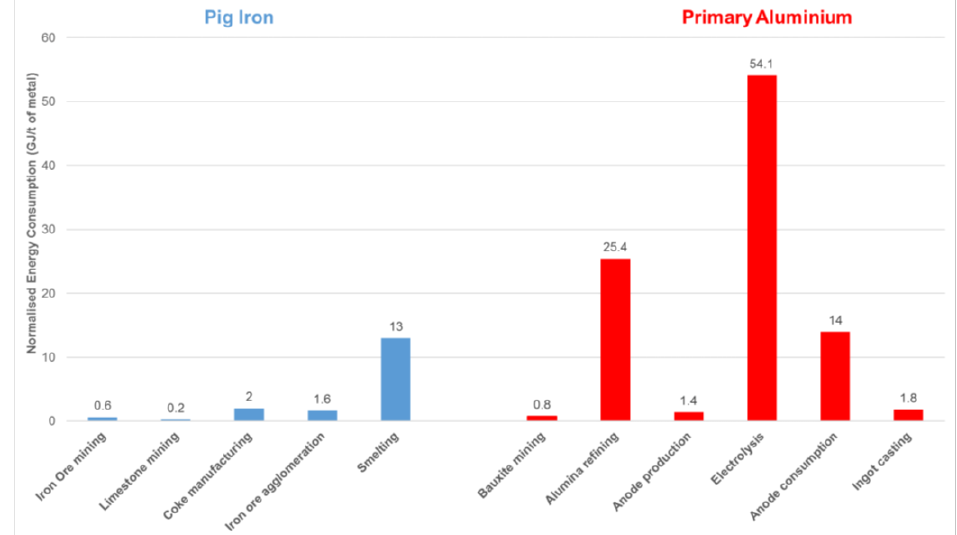
Figure 4. Energy consumption for the production of pig iron and primary aluminum.